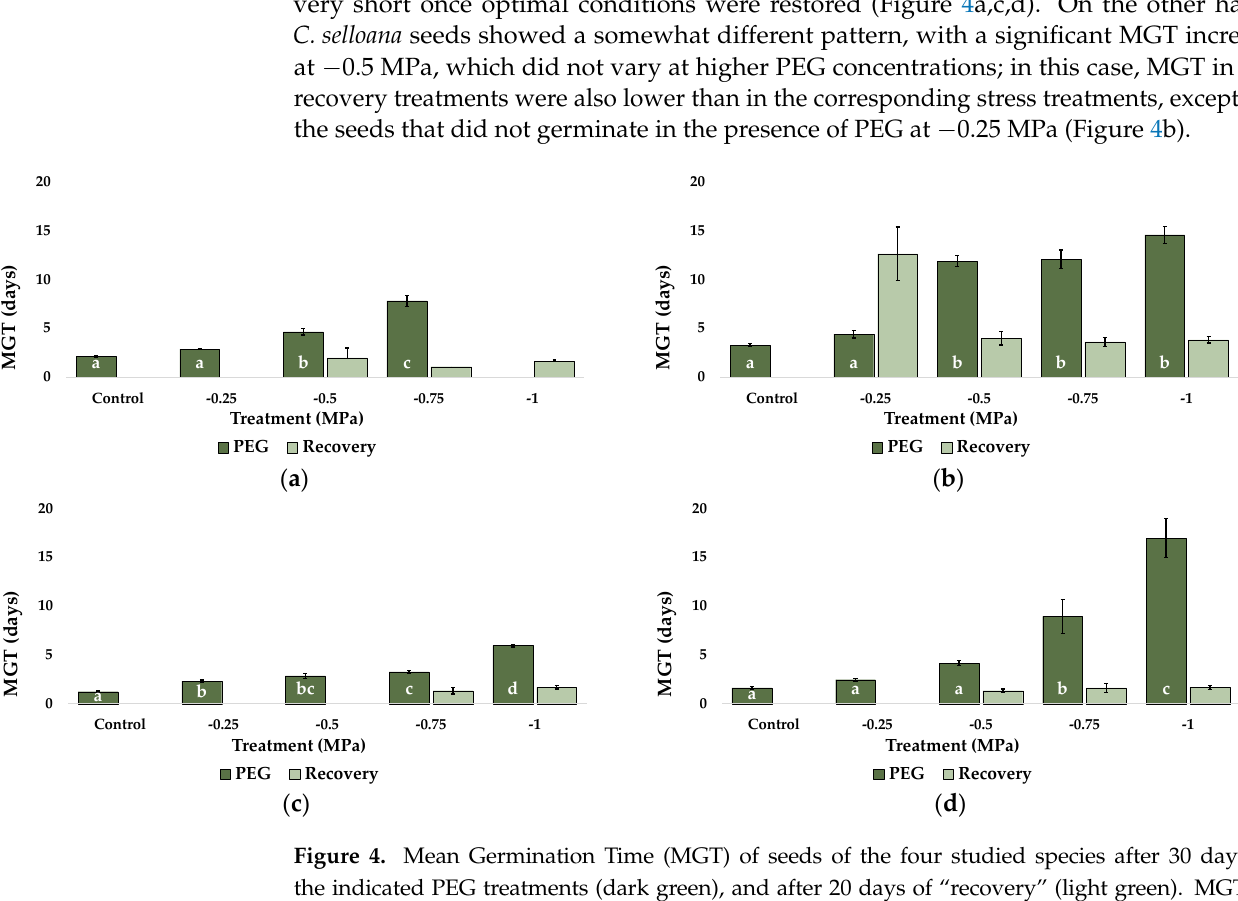
( b ) Figure 5. Germination velocity (1/MGT), in relation to the osmotic potential of the germination me ‐ dium, generated by PEG addition, for the four analysed species, ( a ) for the PEG ‐ treated seeds in the 30 ‐ day initial germination tests, ( b ) after 20 days of “recovery”. Control: germination in distilled water. Considering the competitiveness concept in relation to the germination velocity, the most competitive species was P. alopecuroides , even at the lowest osmotic potentials. On the contrary, C. selloana was the least competitive, at least up to − 0.75 MPa, as its line is below the others (Figure 5a). At the lowest osmotic potential values, this trend changes, and this species increases its competitiveness, becoming the second most competitive as germination velocity stabilises and the line slope decreases. These results agree with